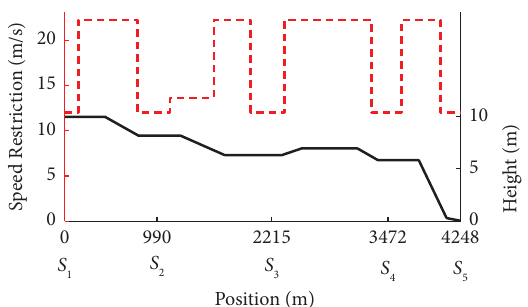
A LGORITHM 2: Coating control algorithm.